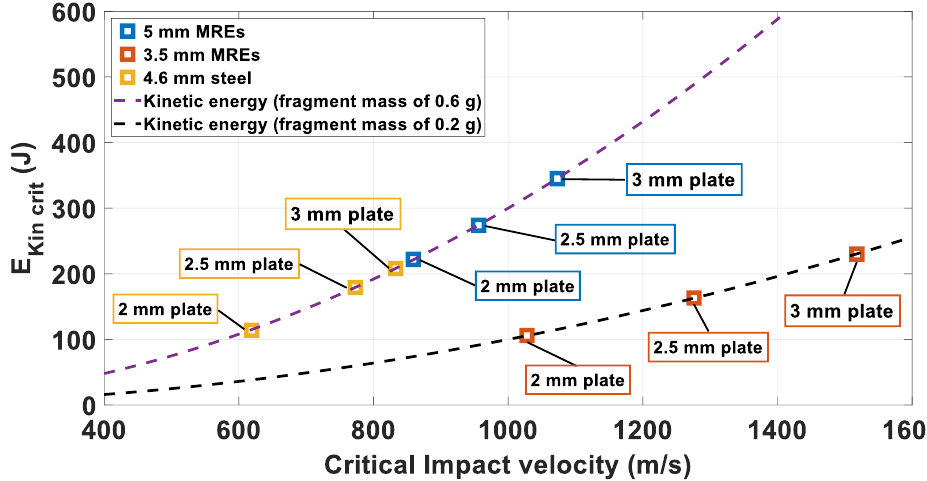
Figure 6. Critical kineti energy over critical impact velocities. The dashed lines indicate the kinetic energies for fragments having mass of 0.6 and 0.2 g, respectively in purple and black, as function of impact velocity. On the othe hand, when compared with the steel fragments, the values of 𝐸 𝐾𝑖𝑛 𝑐𝑟𝑖𝑡 estimated for the 3.5 mm MRE fragmnets are similar, (circa 8% difference). Obviously, the fact that the 3.5 mm MRE fragments weigh 1/3 than the steel fragments is reflected on the CIV , resulting in the translation of the points along the x axis.